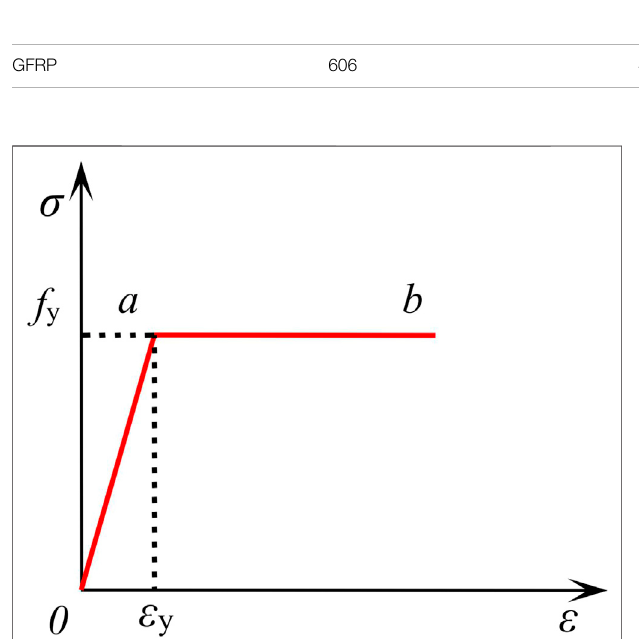
TABLE 2 | Mechanical properties of GFRP bars. FRP bars type